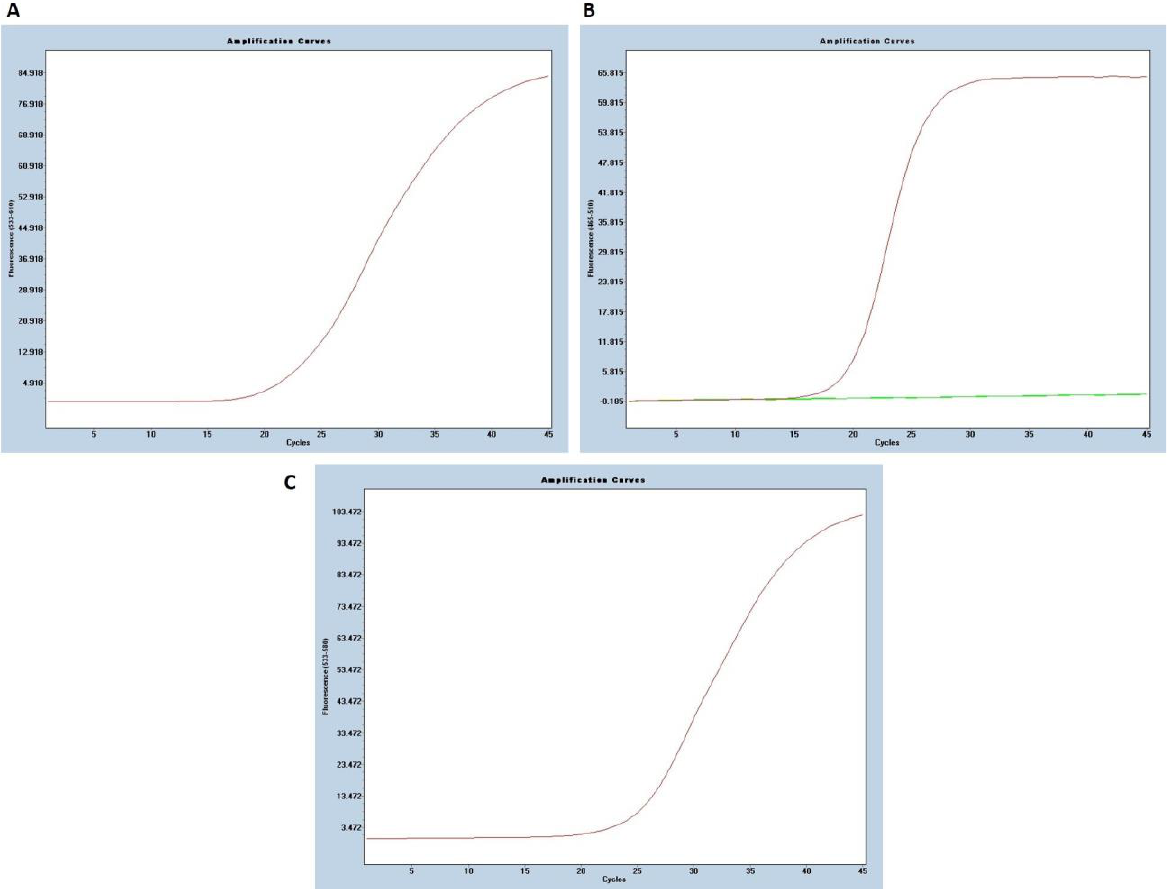
Figure 5. An example of a positive RT-PCR (Vitassay qPCR SARS-CoV-2 kit) result. ( A ) Beta-coronavirus detection in the ROX channel ( N gene), ( B ) SARS-CoV-2 specific amplification in the FAM channel ( ORF1ab gene), ( C ) Signal for the RNA control in the HEX channel.